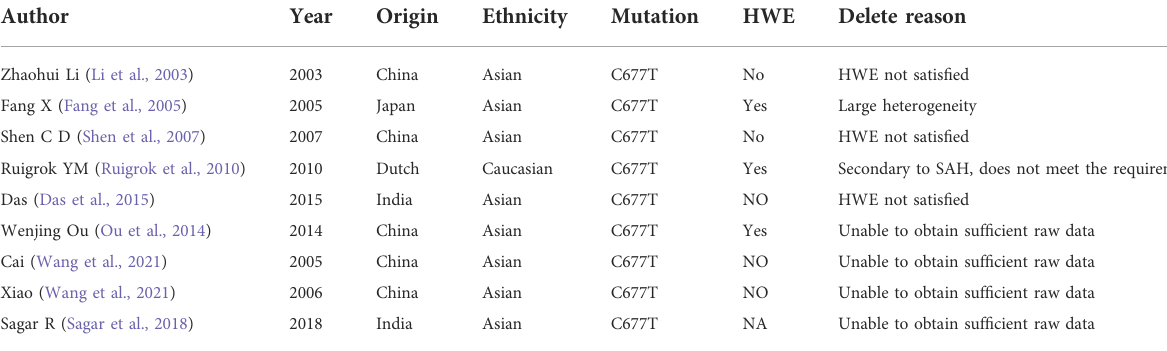
TABLE 2 Information for some strong correlation research not included in the data collection